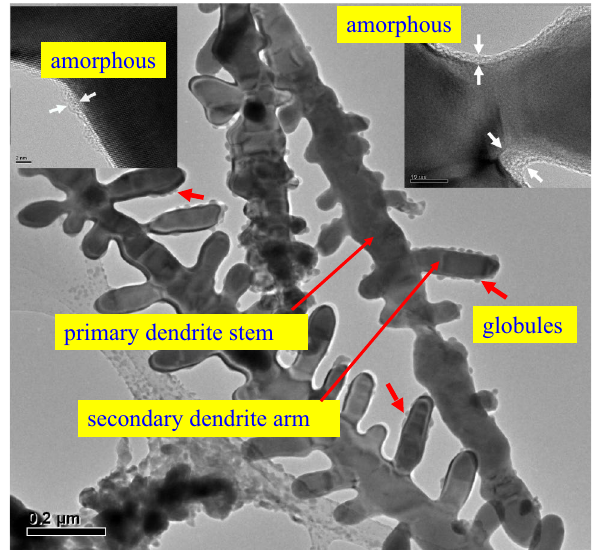
Figure 3. The dendrites were covered by a thin nano amorphous covering, with a thickness of less than 10 nm, as indicated by the arrows shown in the insets. Many of the dendrites had particulate products with dimeter of less than 50 nm adhered to them. The nano particulate attachments existed in the surrounding dendrite arm surface as well as on the dendrite tip. The high aspect ratio structure delineates the preferential growth of the dendrite arm in the longitudinal direction rather than in the radial direction. This indicated that the nano globules adhered to the surface of the dendrite arm contributed little to the growth of the